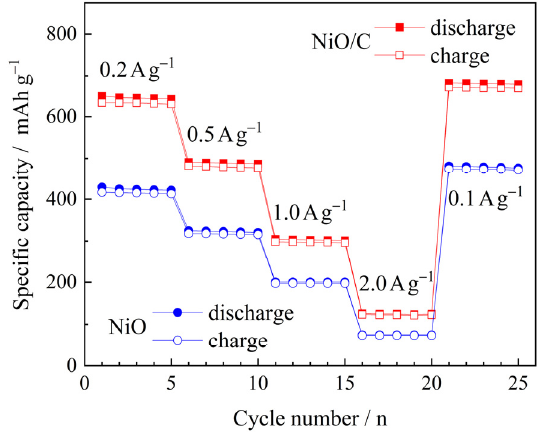
Figure 9. Comparison of the rate capability of two electrodes.